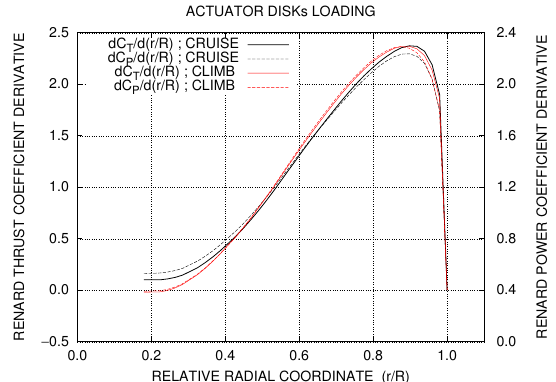
Figure 2. Non-dimensional propellers’ thrust and power radial profiles.